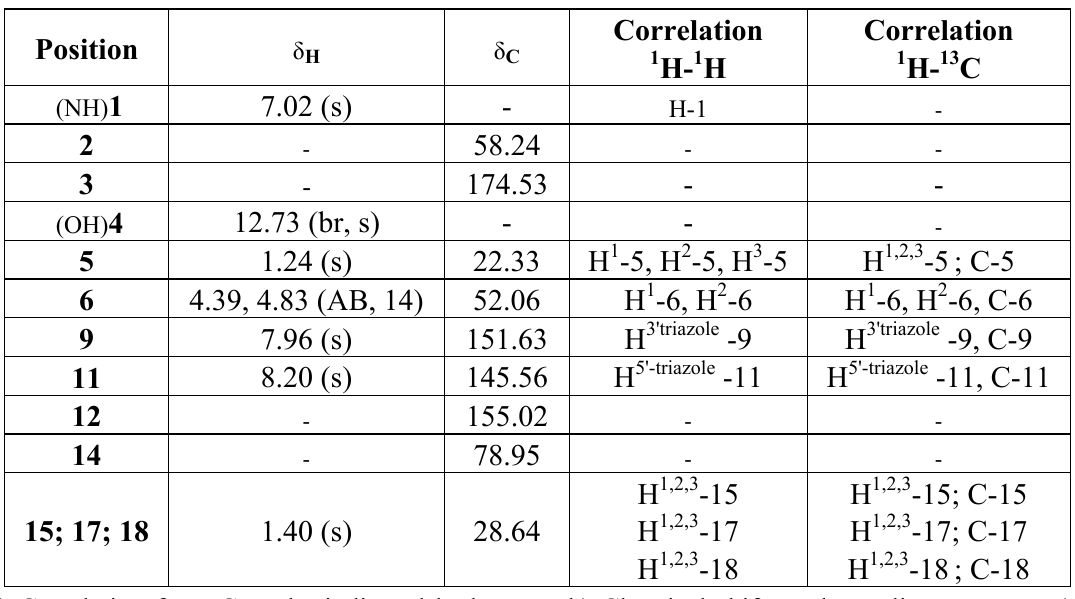
Table 3. 1 H (300 MHz) and 13 C (75.47 MHz) NMR spectral data for 5 in DMSO- d6 , including results obtained by homonuclear 2D shift-correlated and heteronuclear 2D shift- ) a . Chemical shifts ( δ , ppm) and coupling constants ( J , Hz, in correlated HMQC ( 1 J CH parenthesis) b